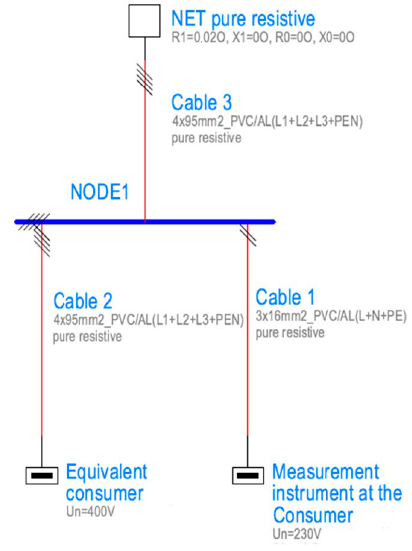
Figure 4. Purely resistive network.